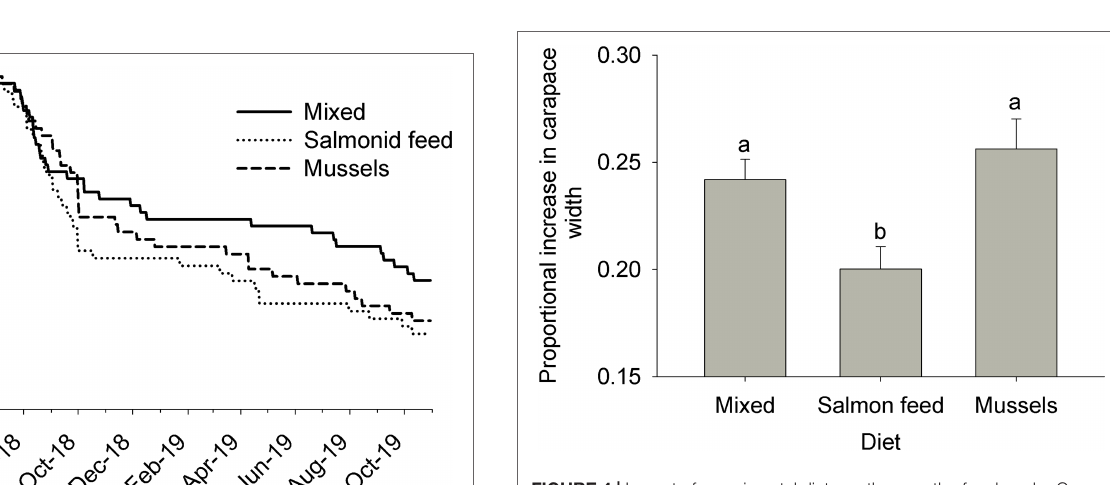
FIGURE 4 | Impact of experimental diets on the growth of rock crabs Cancer irroratus. Replicate values are the average proportional increases in carapace width for each experimental tank. Bars show mean + SE and columns not sharing a common letter are significantly different (Tukey HSD post-hoc tests, n = 5-9). The total number of moults for which growth was recorded was 37, 17, and 29 for the mixed, salmonid feed and mussel diets,